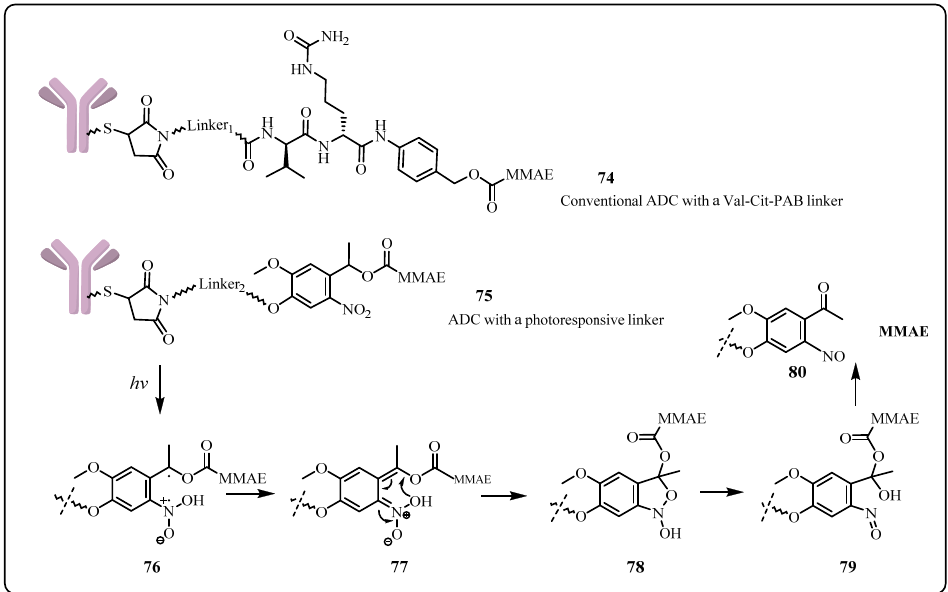
Scheme 9. Different release pathways of conventional ADC and ADC with photoactive